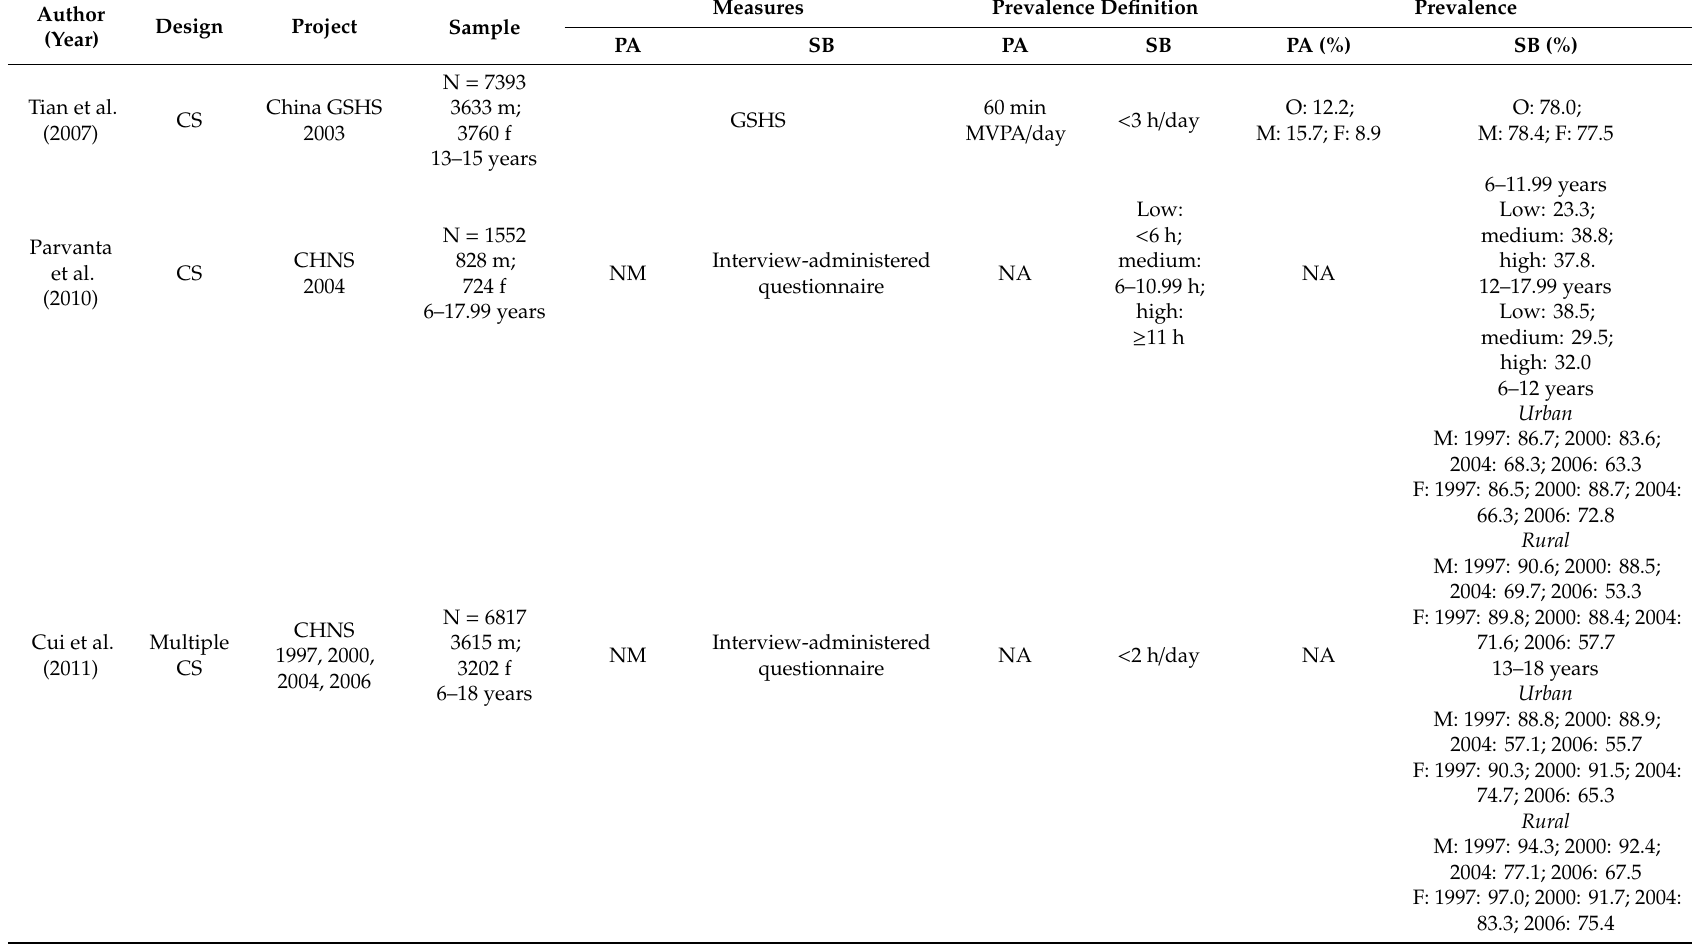
Table 2. Review-study